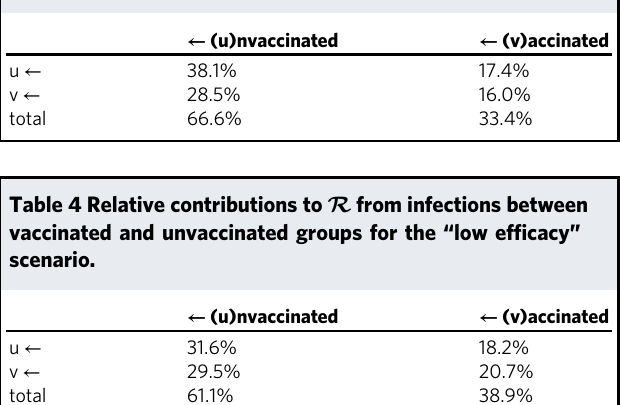
(medium), or 79.3% (low ef fi cacy) of cases — either as infecting,